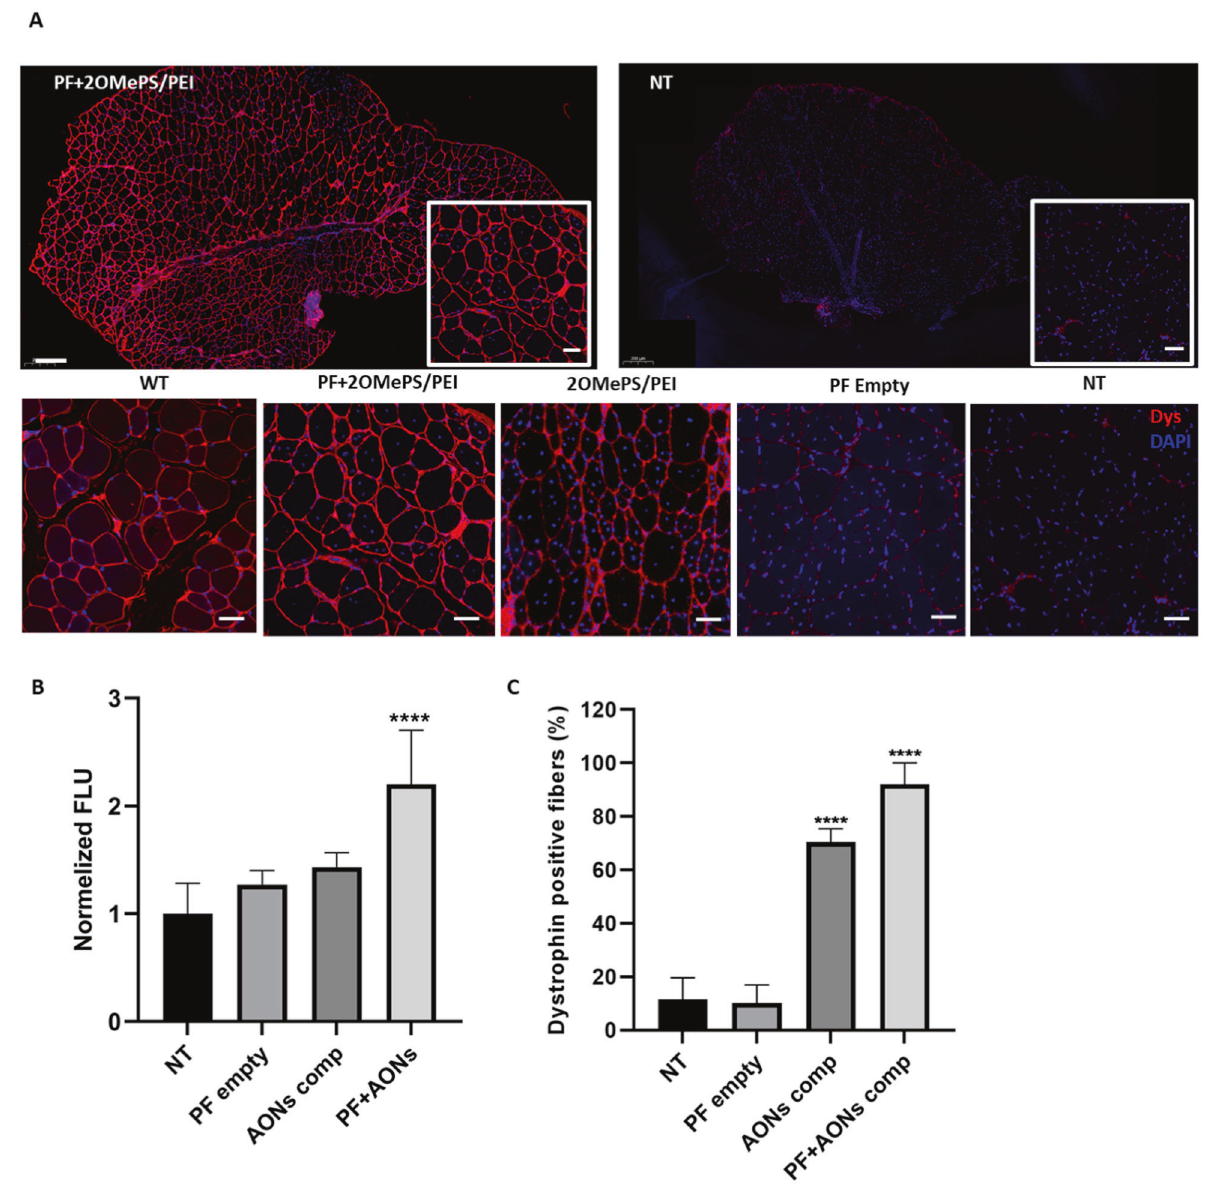
Fig. 5 Dystrophin expression after intramuscular (IM) injection. A Immunohistochemical staining of dystrophin (red) and DAPI (blue) in the TA muscle of C57 WT mice (WT), treated mdx mice 30 days post intramuscular injection of 2OMePS/PEI loaded PF microspheres (PF + 2OMePS/PEI, n = 10), free 2OMePs/PEI polyplexes (2OMePS/PEI, n = 7) or empty PF microspheres (PF empty, n = 3), and non-treated mdx mice (NT, n = 3). Representative images are shown; scale bar = 50 μ m. B Fluorescence intensity to normalized non-treated mdx mice (NT, n = 7) of TA cryosections stained for dystrophin. C Percentage of dystrophin-positive fi bers after intramuscular (IM) injection of 2OMePS/PEI loaded PF microspheres (PF + AONs comp, n = 6), free 2OMePs/PEI polyplexes (AON comp, n = 6), or empty PF microspheres (PF empty, n = 4) compared to non-treated mdx mice (NT, n = 5). Data are presented as mean ± SD, **** P < 0.0001 compared to NT